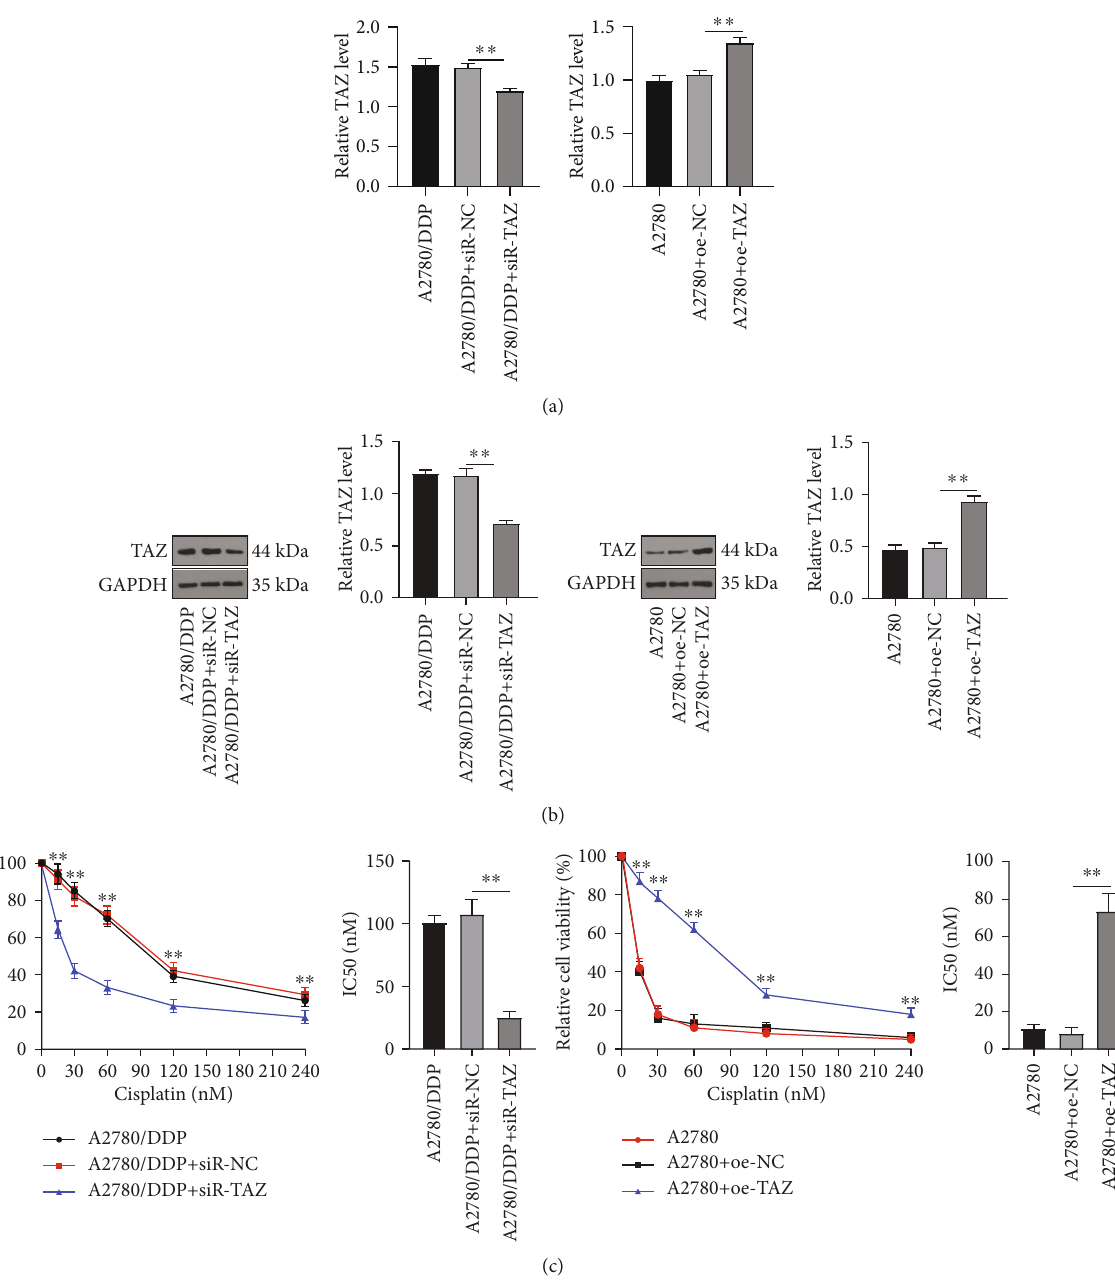
Figure 2: Knockdown of TAZ improved the drug sensitivity of EOC cells. Drug-resistant EOC cells and EOC cells were transfected with siR-TAZ and pcDNA3.1-TAZ, respectively. (a) RT-qPCR was used to detect the expression of TAZ. (b) WB was employed to determine the protein expression of TAZ. (c) After cells were treated with di ff erent concentrations of cisplatin for 48 hours based on transfection with siR-TAZ and pcDNA3.1-TAZ, CCK-8 was employed to measure the drug sensitivity of EOC cells. Cell experiment was repeated three times. Data were shown as mean ± SD , and one-way ANOVA was adopted for comparisons among groups. Tukey ’ s multiple comparisons test was implemented for the post hoc test. ∗ P < 0 : 05 , ∗∗ P < 0 : 01